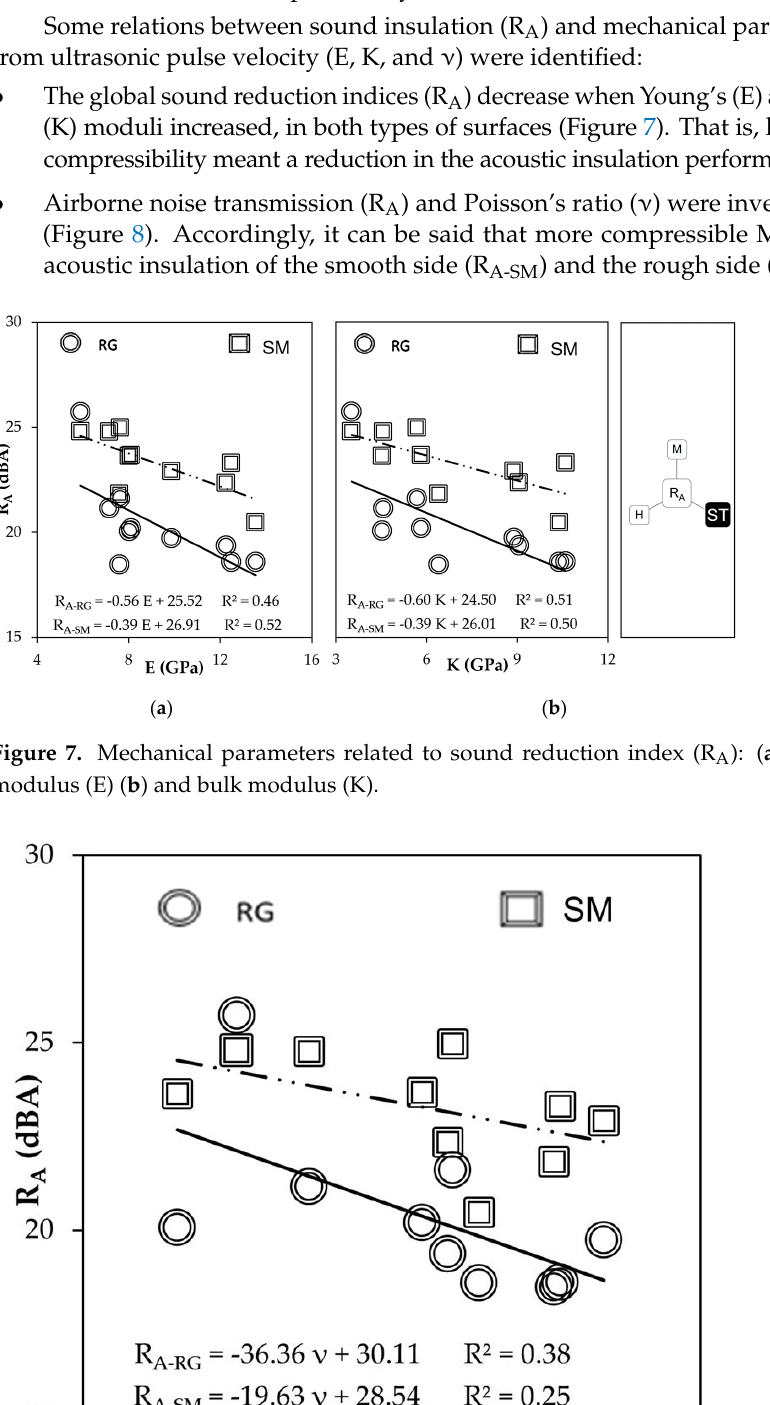
Figure 6. Porosity parameters related to sound reduction index (R bility (P ). V